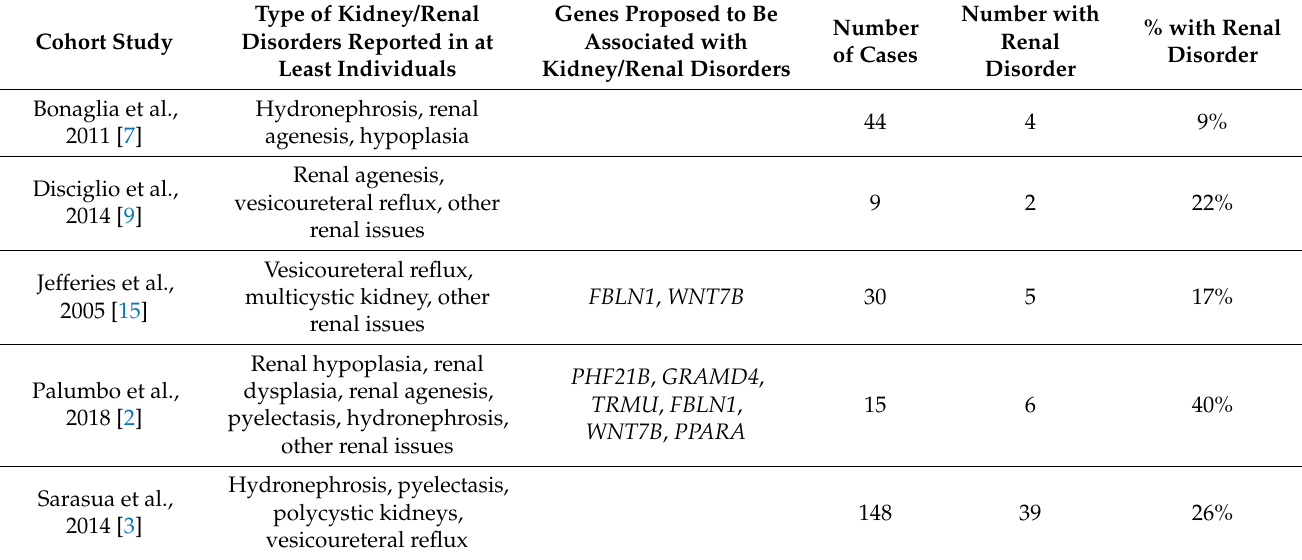
Table 1. Summary of kidney disorders found in Phelan-McDermid syndrome cohort